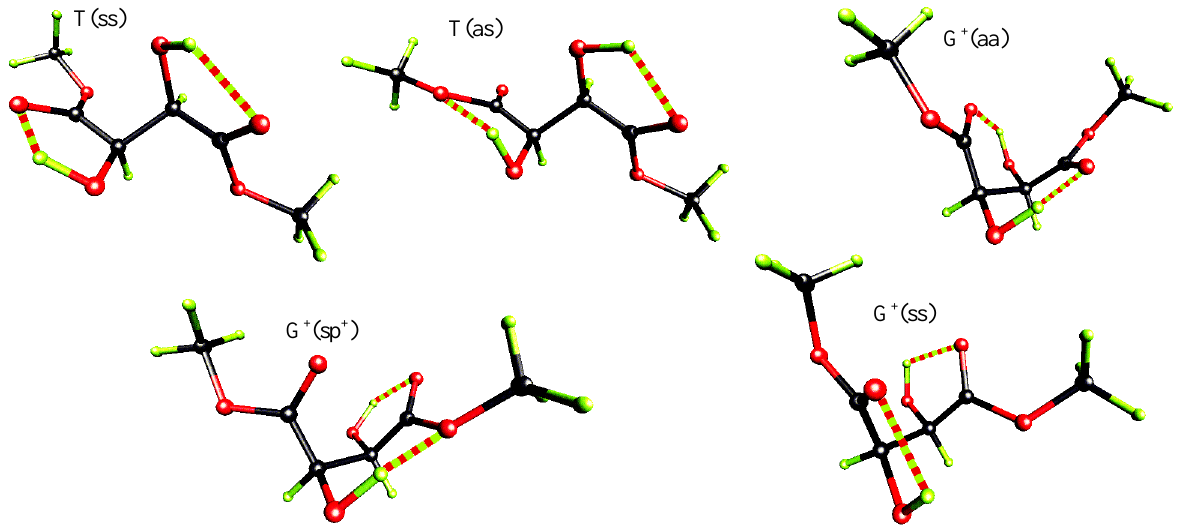
Figure 4. Perspective view of the five lowest energy conformers of (R,R)-tartaric acid dimethyl diester at RHF/6-31G *